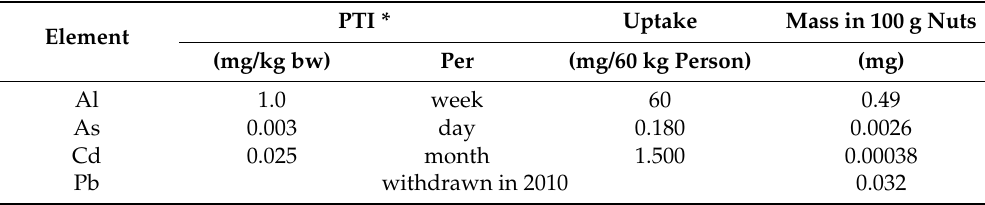
Table 2. Provisional tolerable intakes for selected metals and estimated intake for consumption of 100 g nuts (considering a water content of 3%).